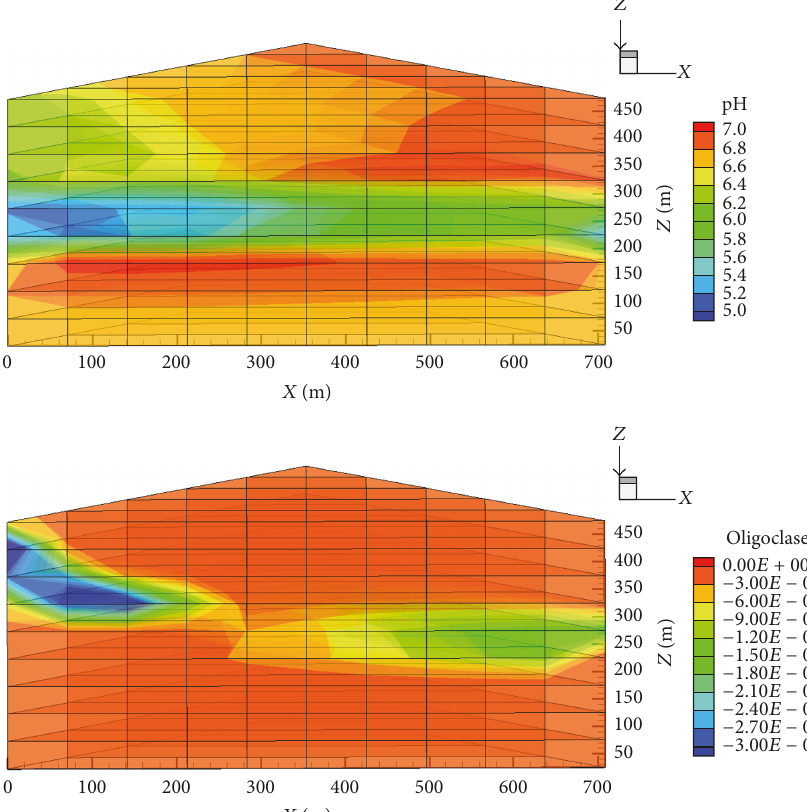
Figure 8: Simulated 3D profiles of pH values and changes of mineral abundance (in volume fraction) for primary mineral oligoclase after 30-year injection of water as a working